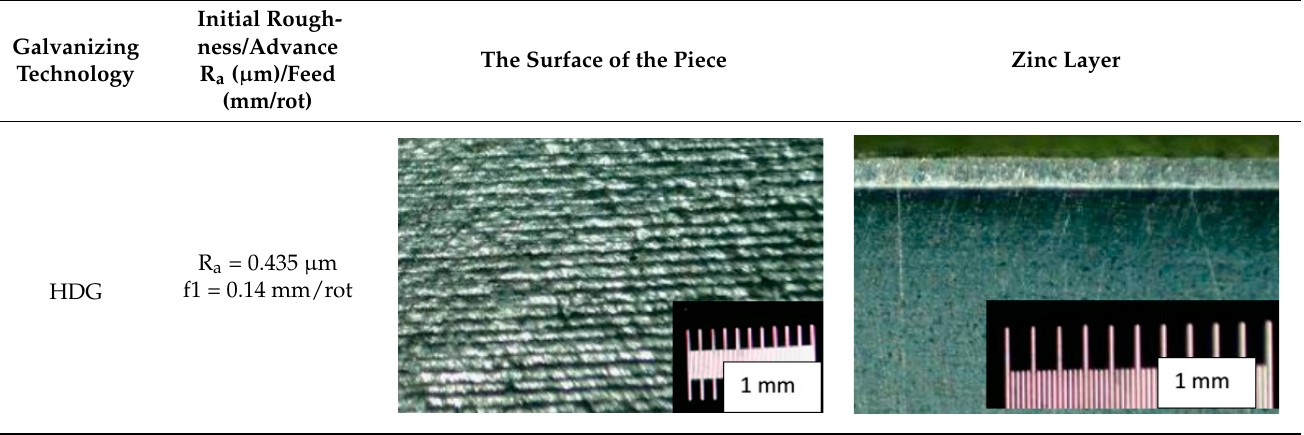
Table 15. The surface of the sample and the structure of the deposited zinc layer depend on the initial roughness obtained by chipping and the applied galvanizing technology.